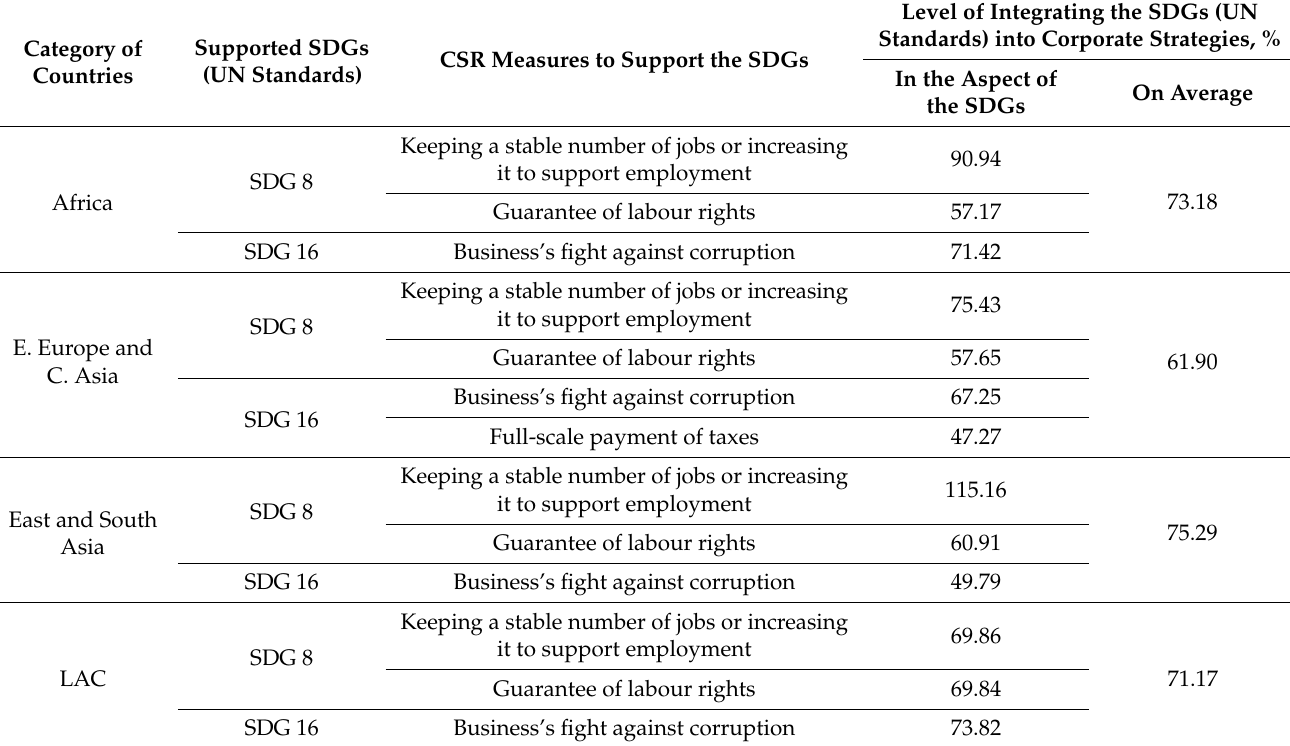
Table 16. The level of integrating the SDGs (UN standards) into corporate strategies in regions of the